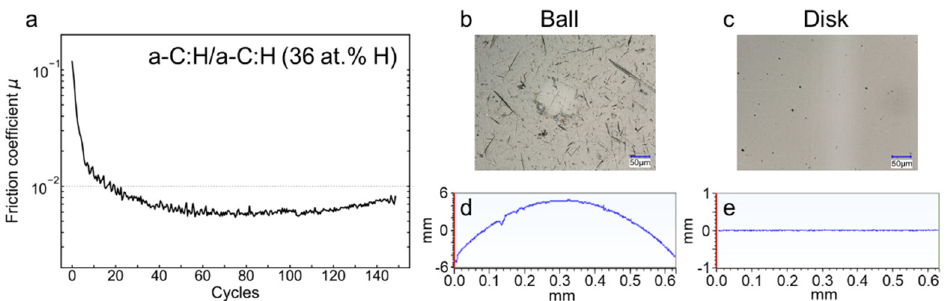
Figure 4. Reciprocating friction tests of self-mated a-C:H with 36 at.% H in UHV. ( a ) Evolution of the friction coefficient µ . Optical images of wear scars on the a-C:H-coated steel ball ( b ) and disk ( c ) after sliding. Depth profiles of wear scars on the a-C:H-coated steel ball ( d ) and disk ( e ) after sliding.